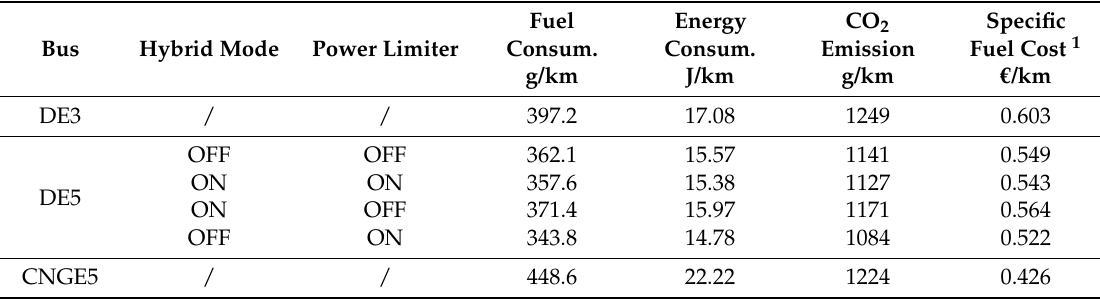
Table 2. Average fuel consumption, CO 2 emissions and fuel cost.